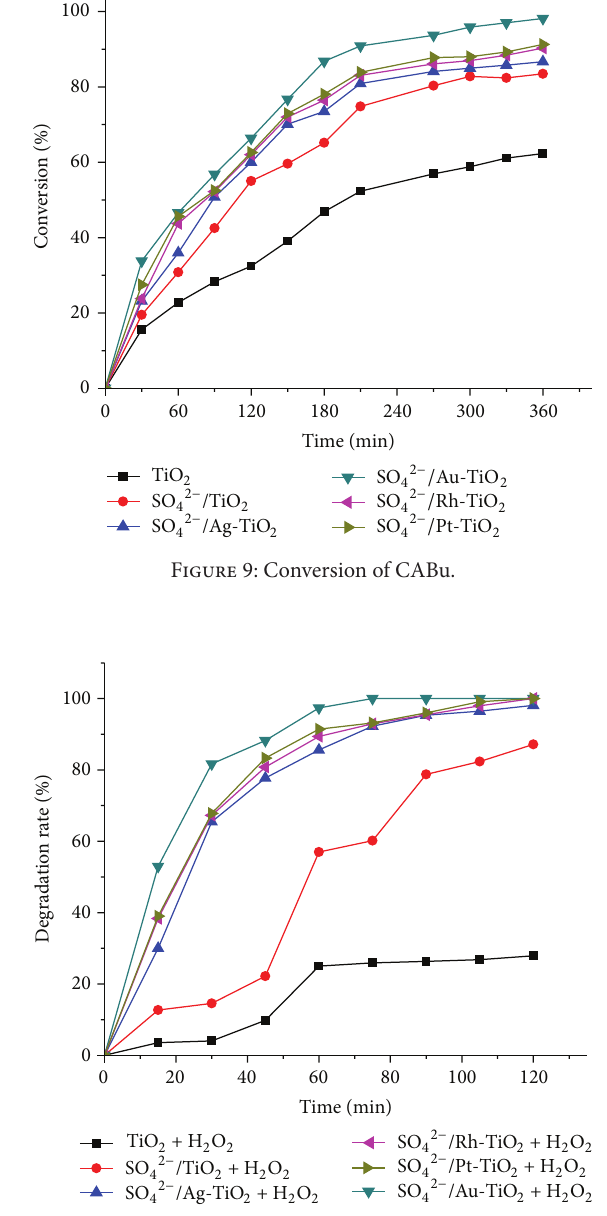
Figure 10: Photocatalytic decomposition of